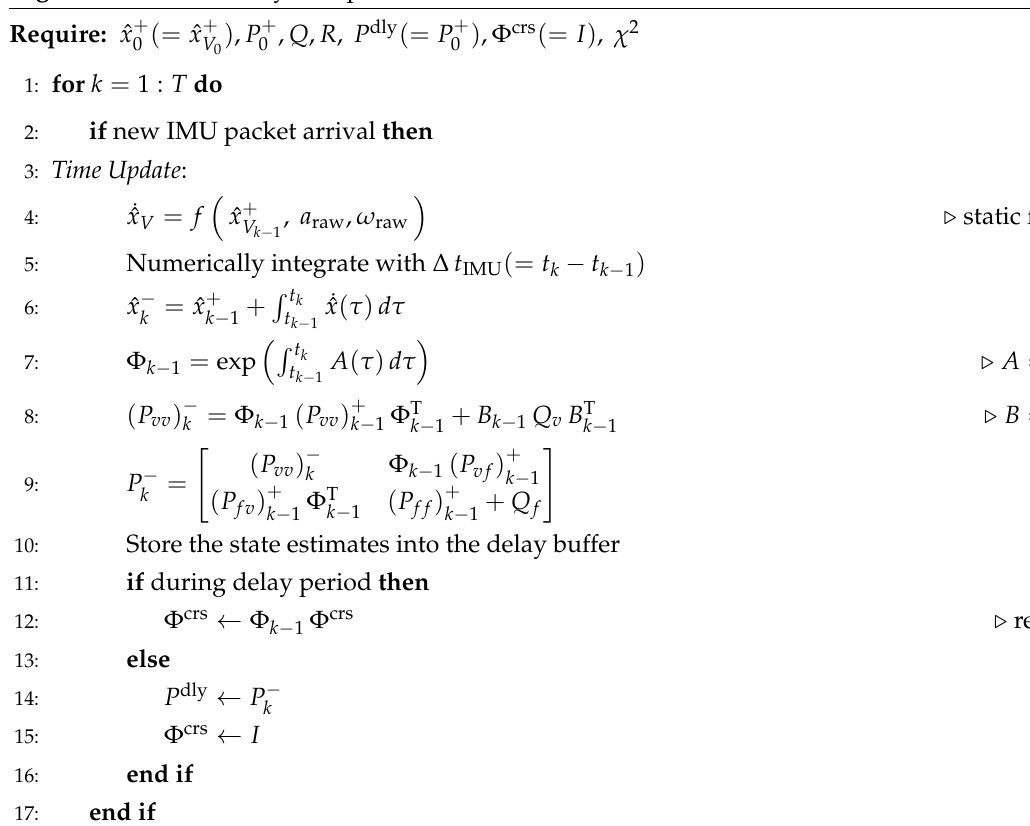
Algorithm 1 The Latency Compensated